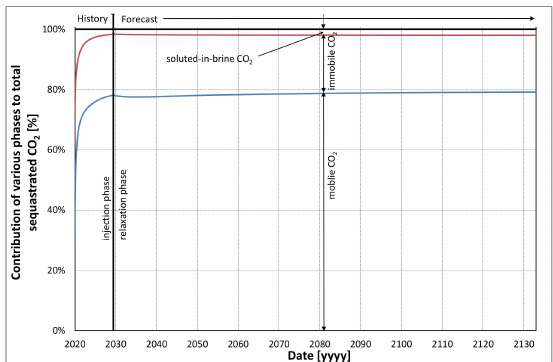
Figure 35. Evolution of total CO 2 injection.